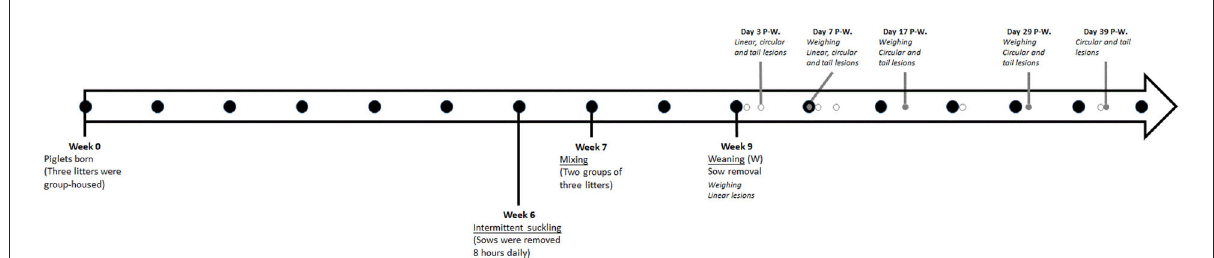
FIGURE1 Timeline of the on-farm management (from Week 0 to 9) and the experimental design (from Week 9 to 15). The black dots indicate the week of the age of the piglets. The gray dots indicate the days post-weaning (P-W.) in which we carried out the experimental work, including piglet weighing or the assessment of linear/circular/tail lesions on piglets. The white dots indicate the days for behavioral observation (days 1, 3, 8, 10, 22, and 38 post-weaning).